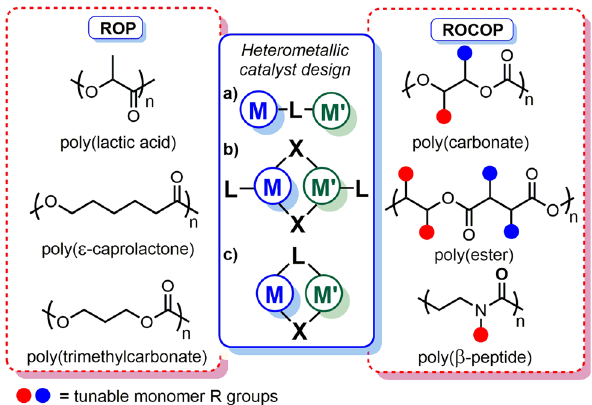
Fig. 1 Heterometallic structural motifs and polymerisation products highlighted in this review. L = ligand, X = bridging or exchangeable ligand (e.g. nitrogen, oxygen,